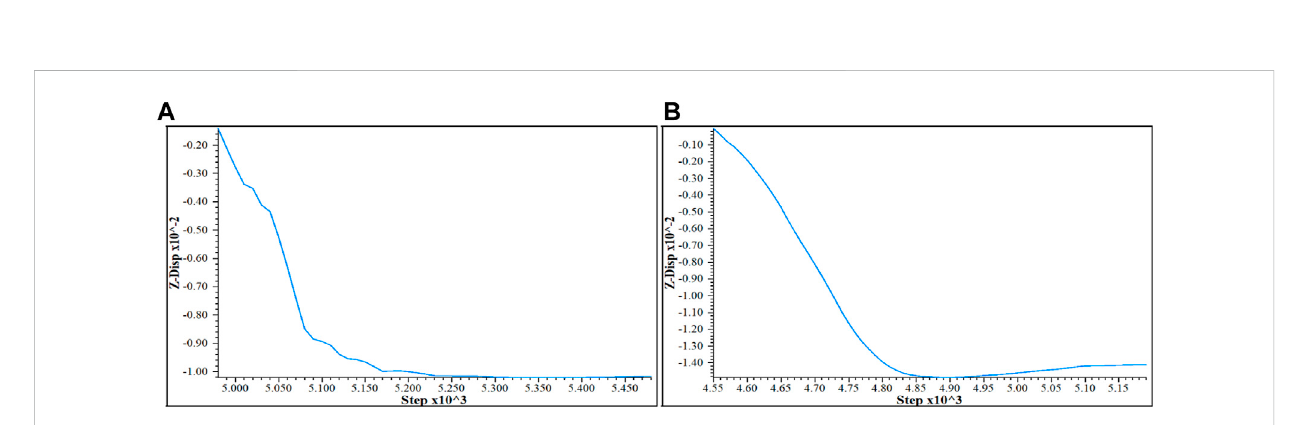
FIGURE 11 Vertical displacement curve when the elastic modulus changes. (A) Vertical displacement curve when the elastic modulus is 5.2 GPa (with support). (B) Vertical displacement curve when the elastic modulus is 79.8 GPa (with support).